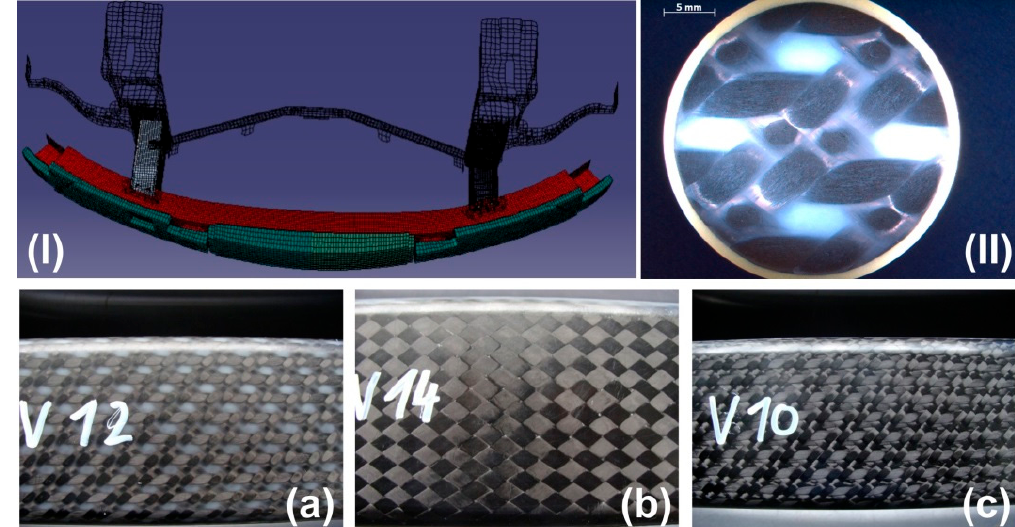
Figure 1. CFRP braided bumper bracket: ( I ) bumper bracket (red) with pedestrian collision protection (green) and crash tubes (behind the bumper bracket); ( II ) micrograph of the representative volume of the BMW serial configuration ± 45 ◦ with 0 ◦ filler yarn; bumper bracket configurations: ( a ) 4 layers ± 45 ◦ with 0 ◦ filler yarn; ( b ) 9 layers ± 30 ◦ ; ( c ) 4 layers ± 45 ◦ with 0 ◦ filler yarn and unidirectional 0 ◦ layers between every braided layer.